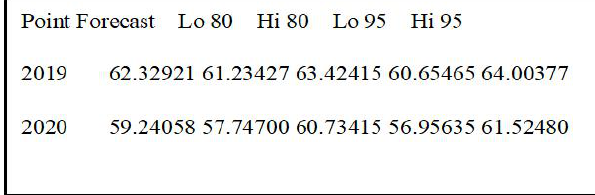
Table 8. Data Set of 47 obs. of 3 variables Table 9. Confusion